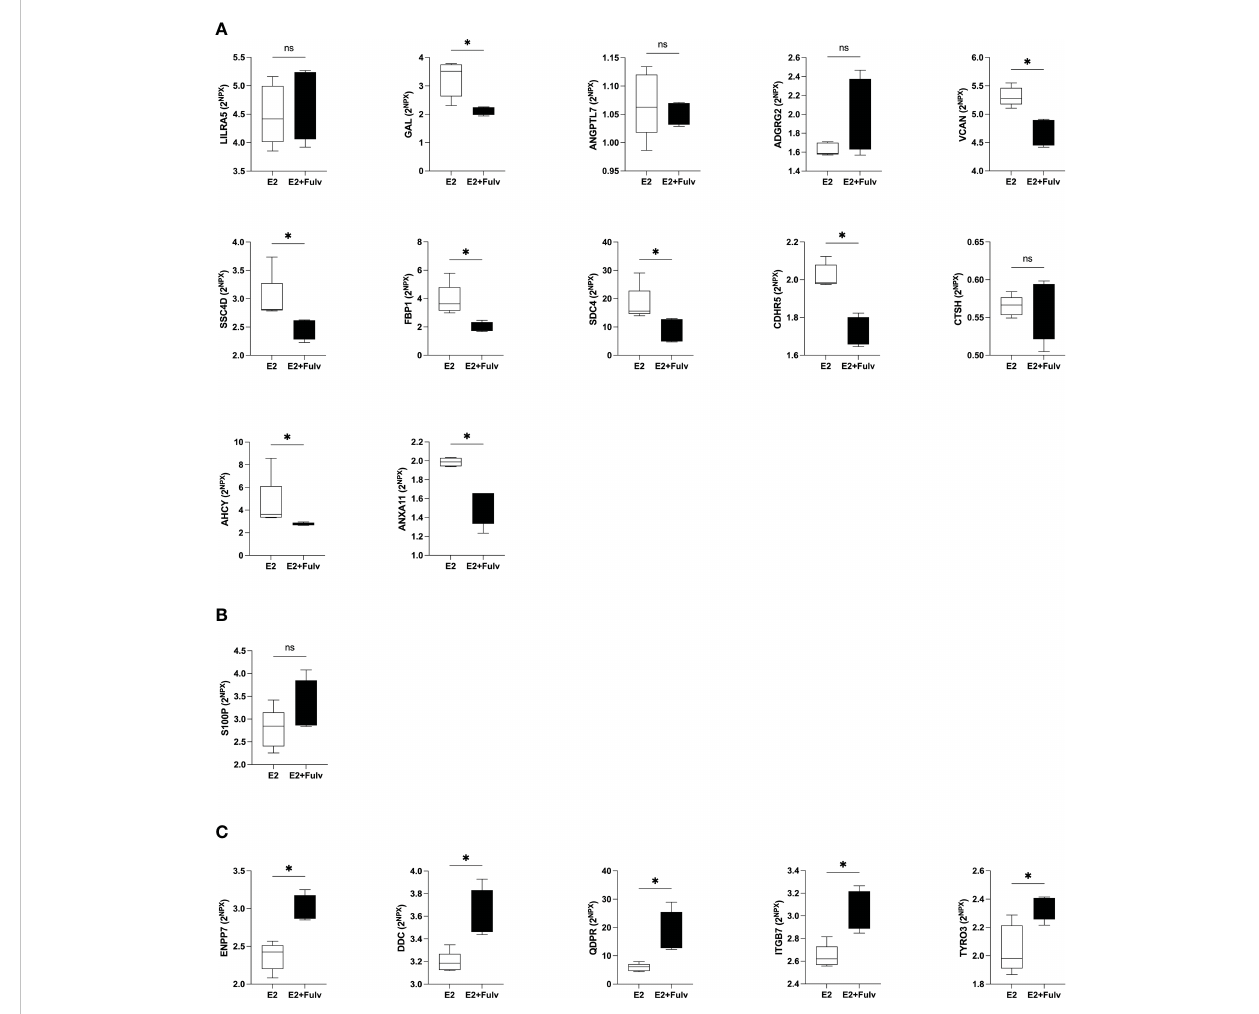
FIGURE 8 Hormonal regulation of extracellular metabolic proteins in estrogen receptor (ER+) experimental breast cancer. Oophorectomized athymic mice supplemented with physiological levels of estradiol (E2) were injected with MCF-7 cells into the dorsal mammary fat pads. At similar tumor sizes, mice either continued with E2 or were additionally treated with fulvestrant (E2+Fulv) (5 mg/mouse every 3 days, s.c.). Size-matched tumors from the different treatment groups underwent microdialysis for sampling of proteins from the extracellular space in vivo . (A) Proteins that were signi fi cantly positively correlated with estradiol in human breast tissue. (B) Protein that was up-regulated in premenopausal breast tissue but failed to show any correlation with local breast E2 levels. (C) Proteins that were signi fi cantly negatively correlated with estradiol in human tissue. * P <0.05, ns= not signi fi